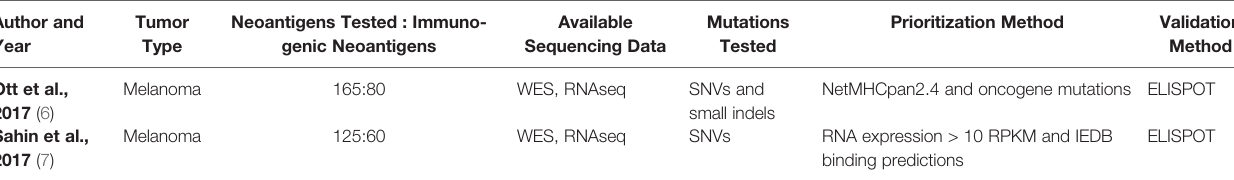
TABLE 8 | Available sets of MHC class II-restricted neoantigens validated to elicit a CD4+ T cell